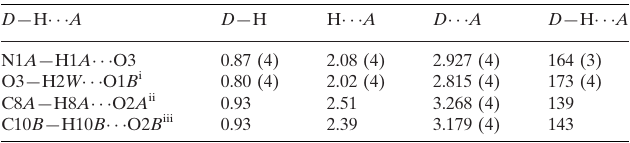
Hydrogen-bond geometry (A˚ , (cid:3)